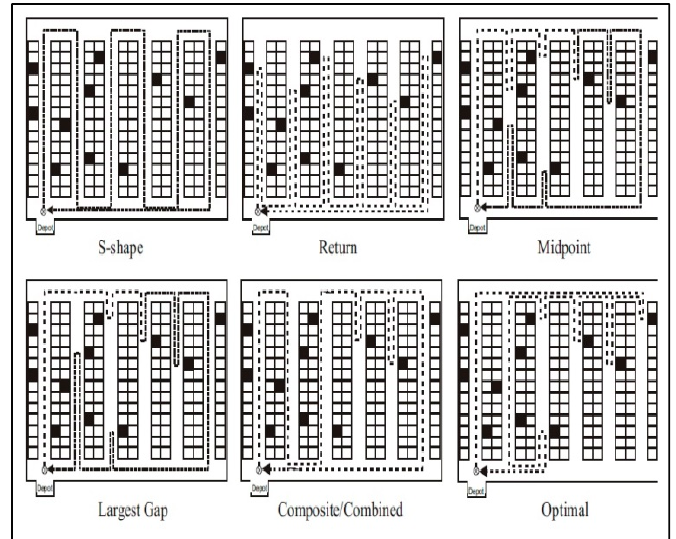
Figure 12. Different implementation for reviewed heuristic methods. Figure 12. Di ff erent implementation for reviewed heuristic methods.